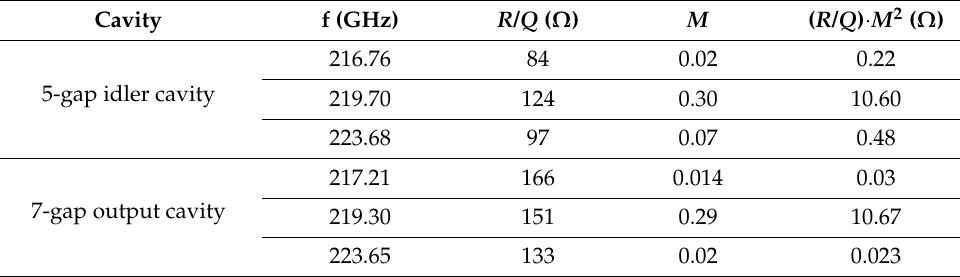
Table 2. The performance of the operating mode and its adjacent modes.